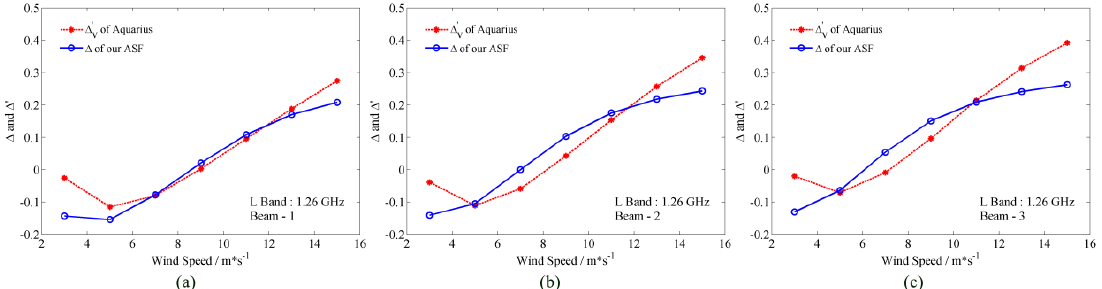
Figure 7. Comparison of Δ radio and Δ′ calculated by Aquarius observations versus wind speeds at L-band. Red dash lines with stars are Δ′ calculated in liner scale with Aquarius observations. Blue solid lines with open circles are Δ radios of our ASF. ( a ) Beam 1; ( b ) Beam 2; ( c ) Beam 3.